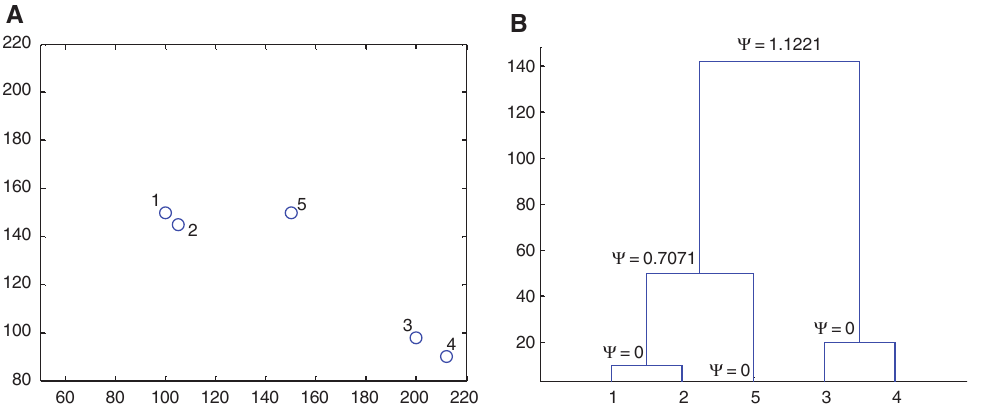
Figure 21: Hierarchical clustering illustration of (A) sample and (B) dendrogram representing binary joints and inconsistency coefficient at each joint level.